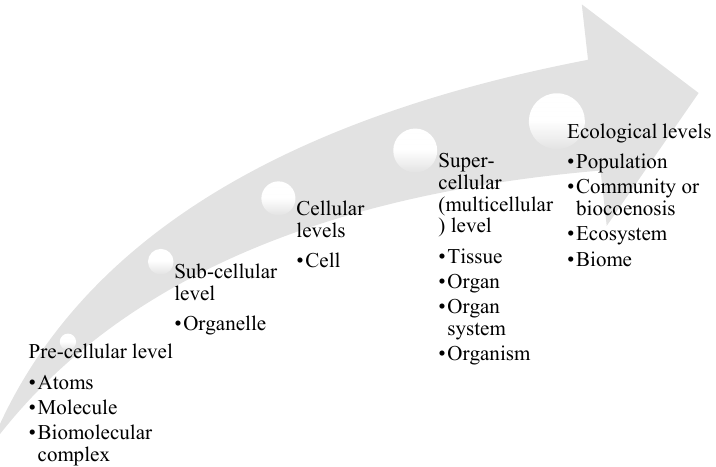
Figure 10. Biological organization scales.